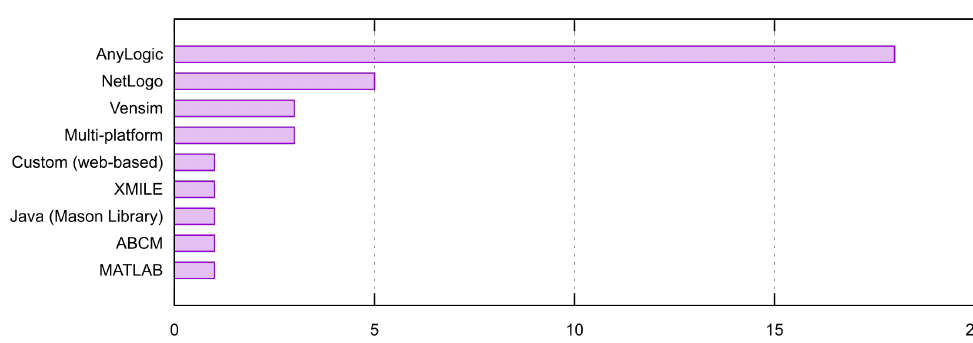
Figure 7. A breakdown of reviewed papers by the modeling platform for hybrid SD-AB